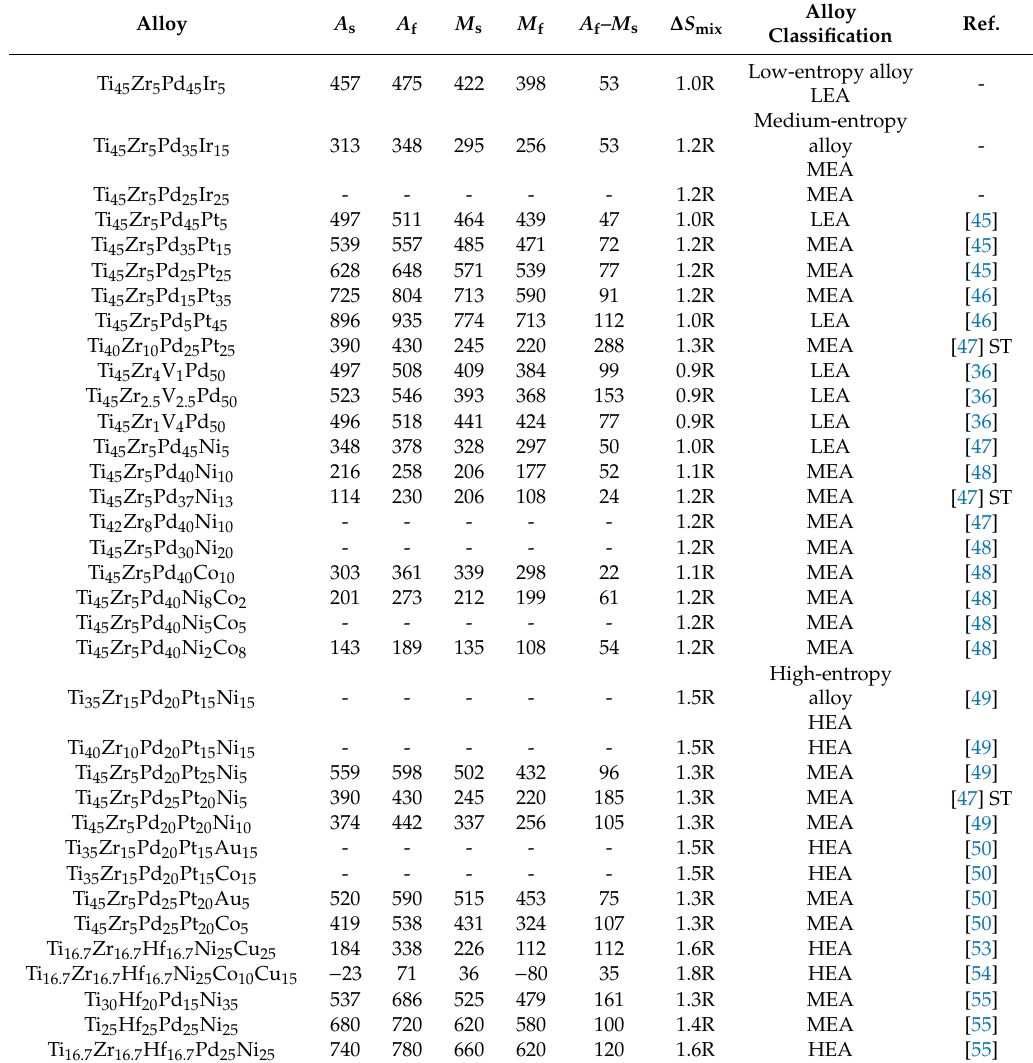
Table 2. Martensitic transformation temperature of multi-element alloys. Alloy